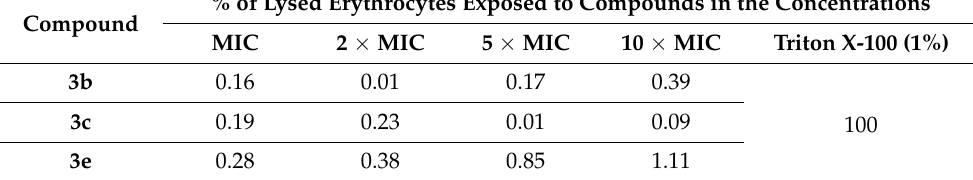
Table 9. Haemolytic effect (% of haemolysis) of